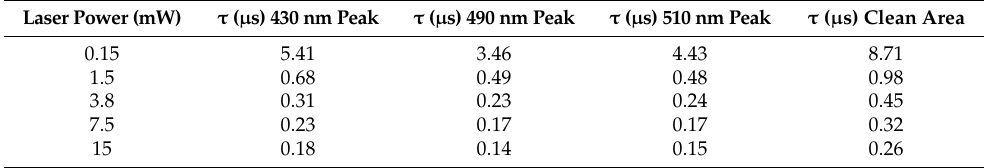
Table 3. Carrier lifetime data on different SFs defect compared with values on the clean